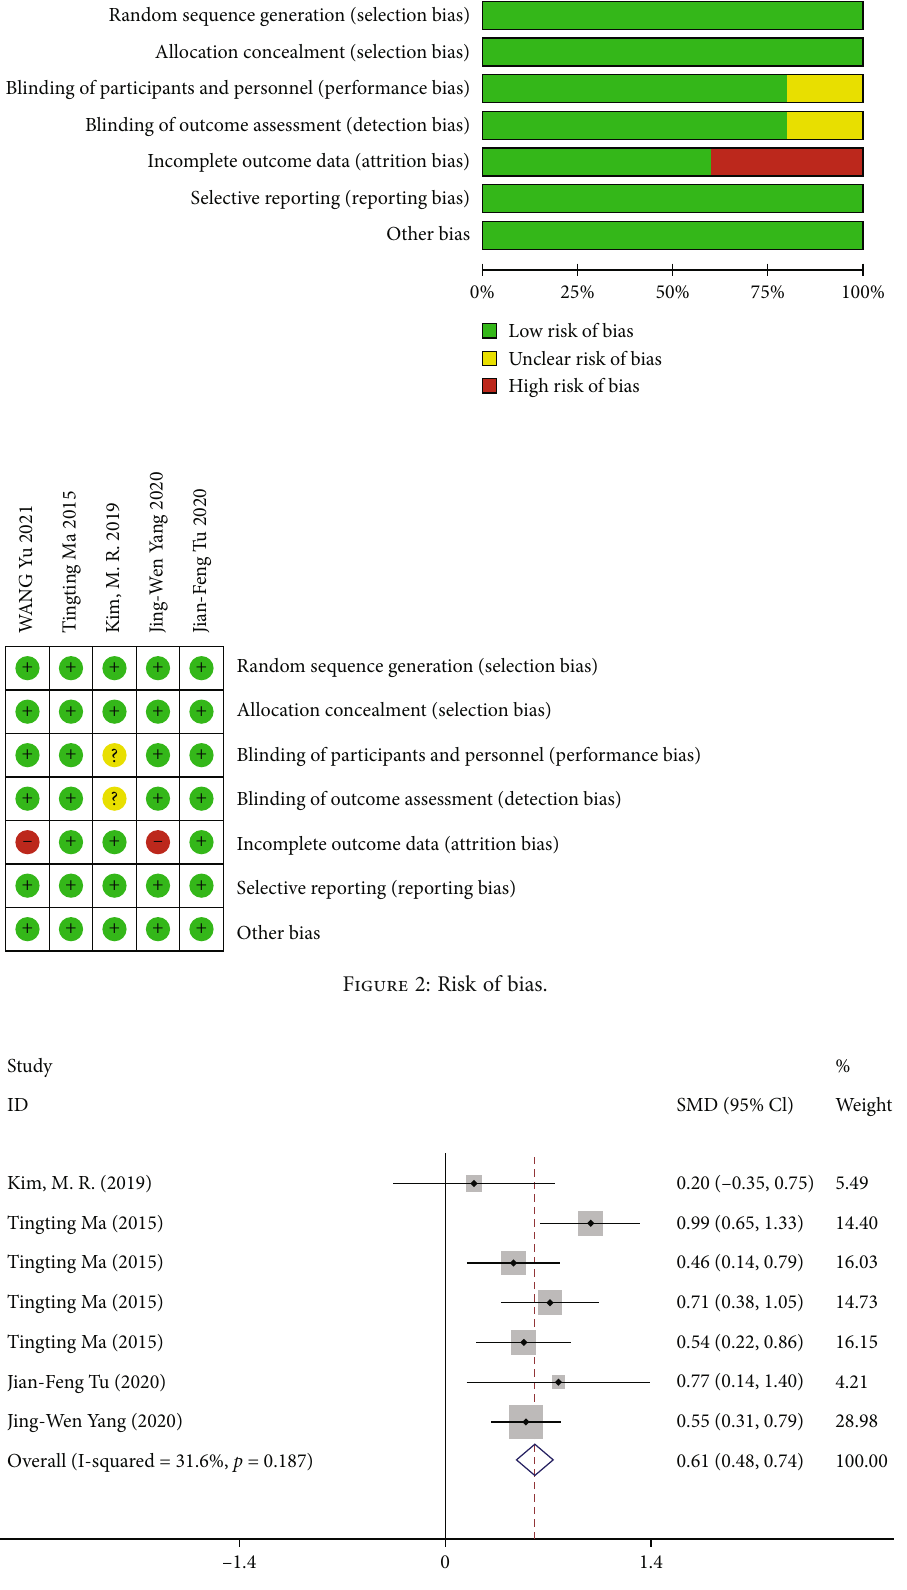
Figure 3: Forest plot of comparison. Acupuncture vs. sham acupuncture. Outcome: change of NDI from baseline to week